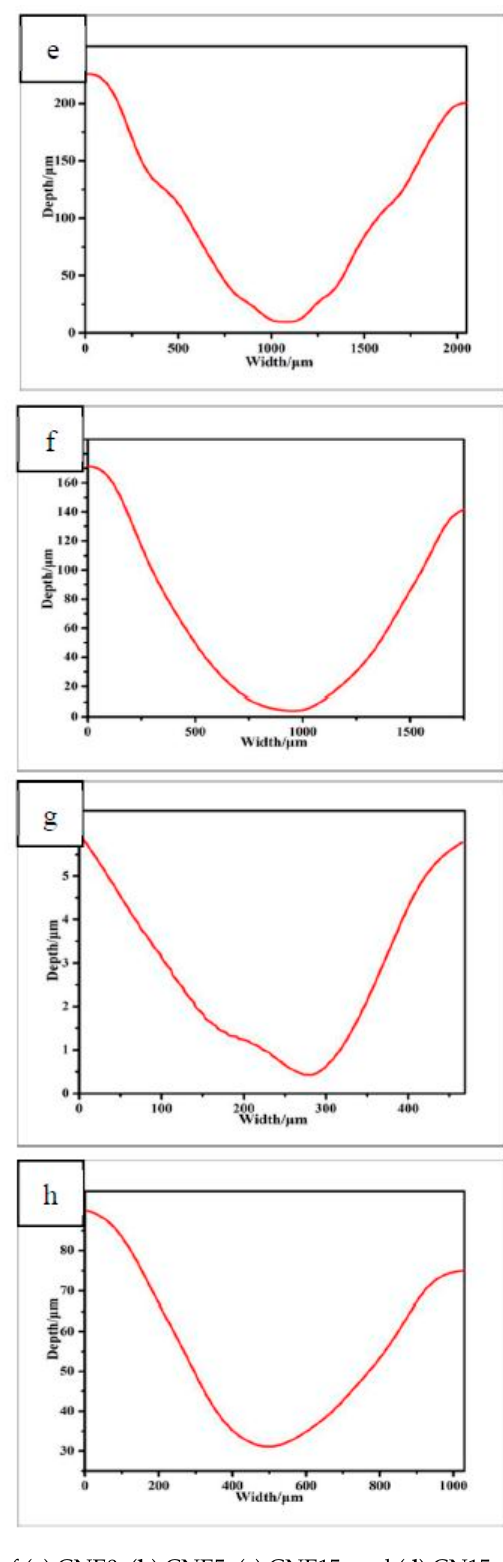
Figure 5. Non-contact, three-dimensional surface of ( a ) CNE0, ( b ) CNE5, ( c ) CNE15, and ( d ) CN15; ( e – h ) are the outline of the corresponding wear scar.